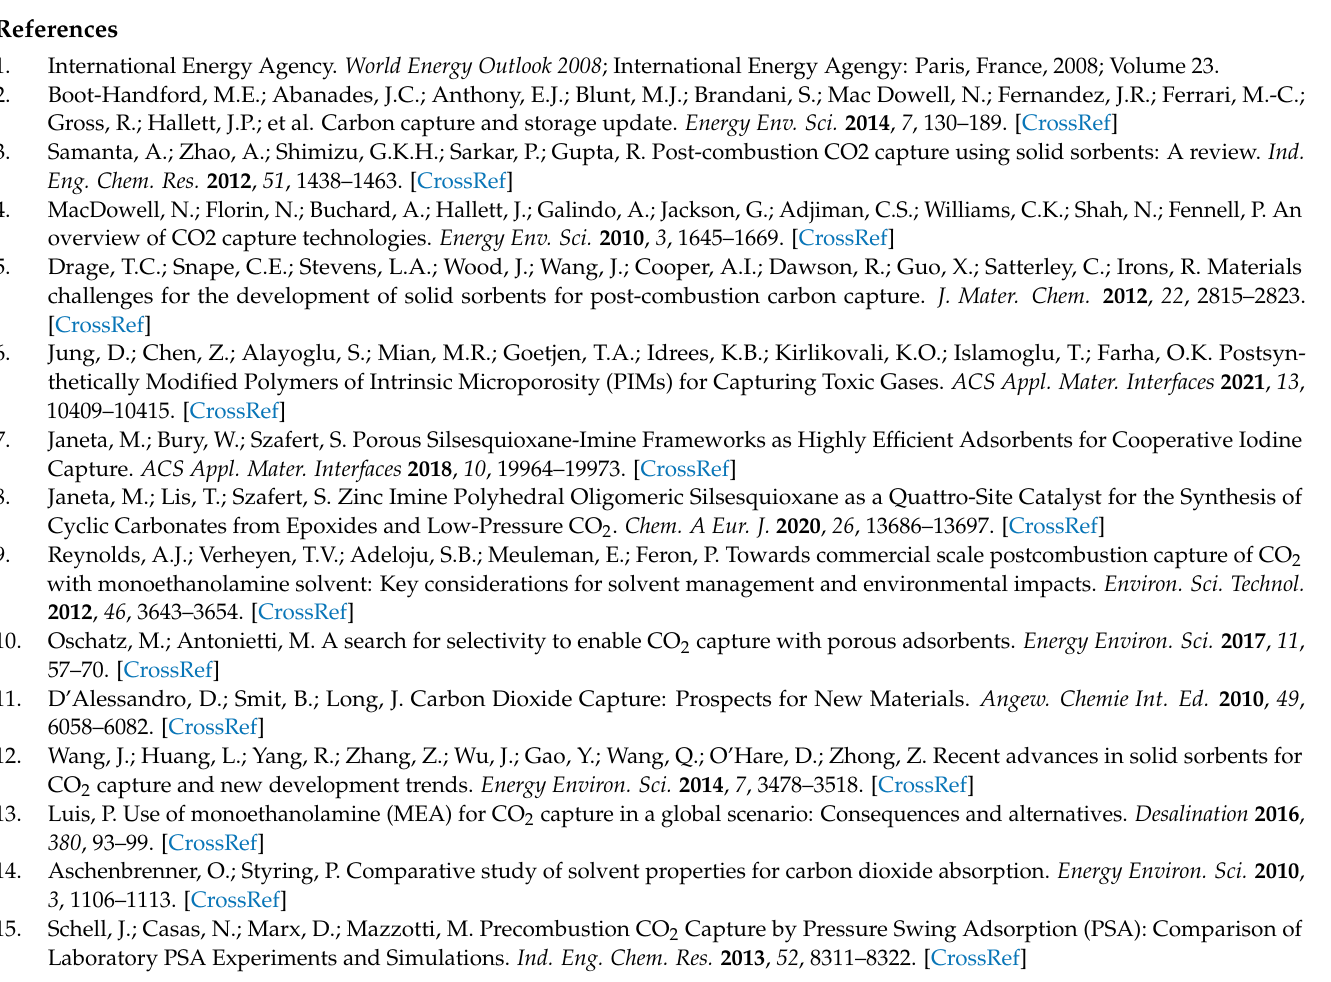
Figure S6 Apparatus setup Table S1: HCP prepation, Table S2: FTIR, Table S3: Sample masses, Table S4: Kinetic 10 Bar 25 ◦ C CO2 uptakes, Table S5 Kinetic 20 bar 25 ◦ C CO2 uptakes, Table S6: Kinetic CO2 uptake at 25 ◦ C, Table S9: High pressure CO2 uptake at 40 ◦ C, Table S10: High pressure N2 uptake at 25 ◦ C, Table S11: High pressure N2 uptake at 40 ◦ C, Table S12: Pressure Swing, Table S13: